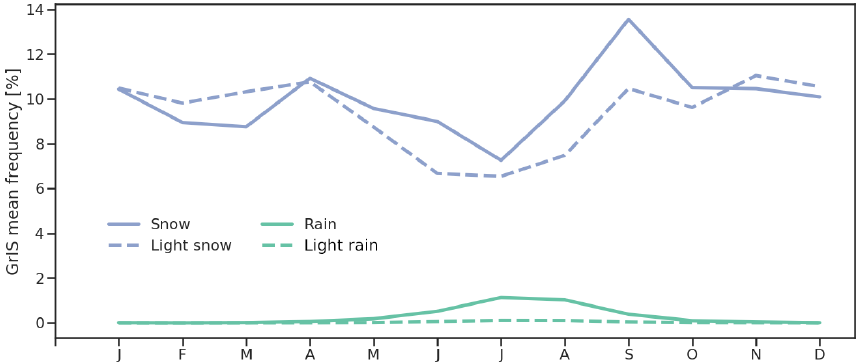
Figure 2. Seasonal cycle (January to December) of Greenland Ice Sheet averaged snowfall and light snowfall (blue: solid, dashed) and rainfall and light rainfall (green: solid, dashed) frequency obtained by CloudSat cloud-profiling radar observations (2CPC: 2006–2016).